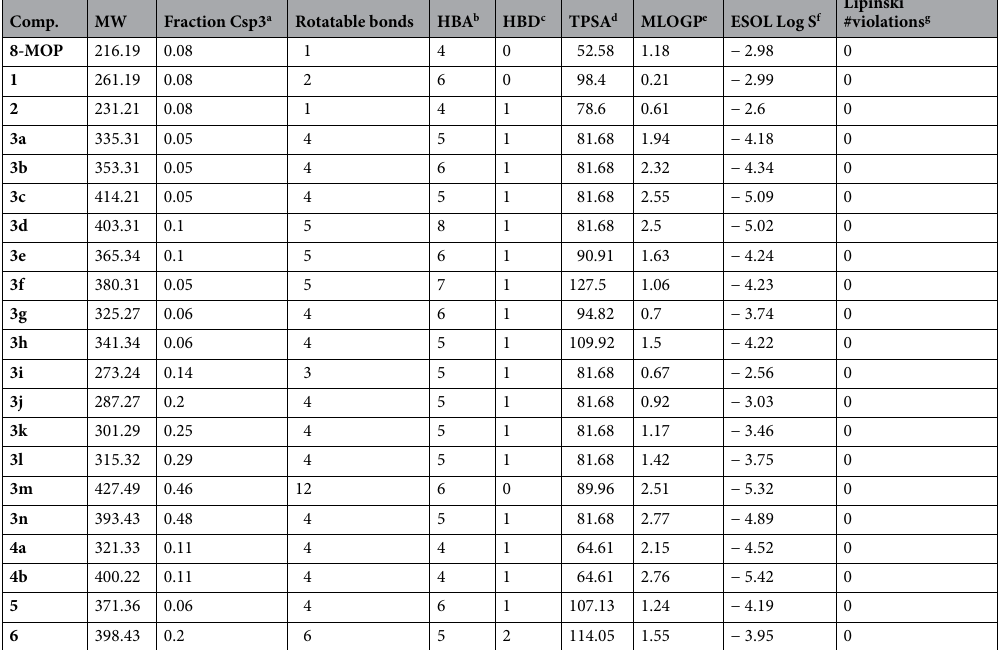
Table 3. Predicted physicochemical properties of psoralen derivatives 46,47 . a The ratio of sp 3 hybridized carbons over the total carbon count of the molecule; b hydrogen bond acceptor; c hydrogen bond donor; d topological polar surface area [Å 2 ]; e lipophilicity: Moriguchi octanol–water partition coefficient (MLOGP) is based on quantitative structure-logP relationships, by using topological indexes; f log of the aqueous solubility measured in mol L −1 , according to the Estimating Aqueous Solubility (ESOL); g Lipinski’s rule of five (MW ≤ 500, MLogP ≤ 4.15, HBA ≤ 10, and HBD ≤